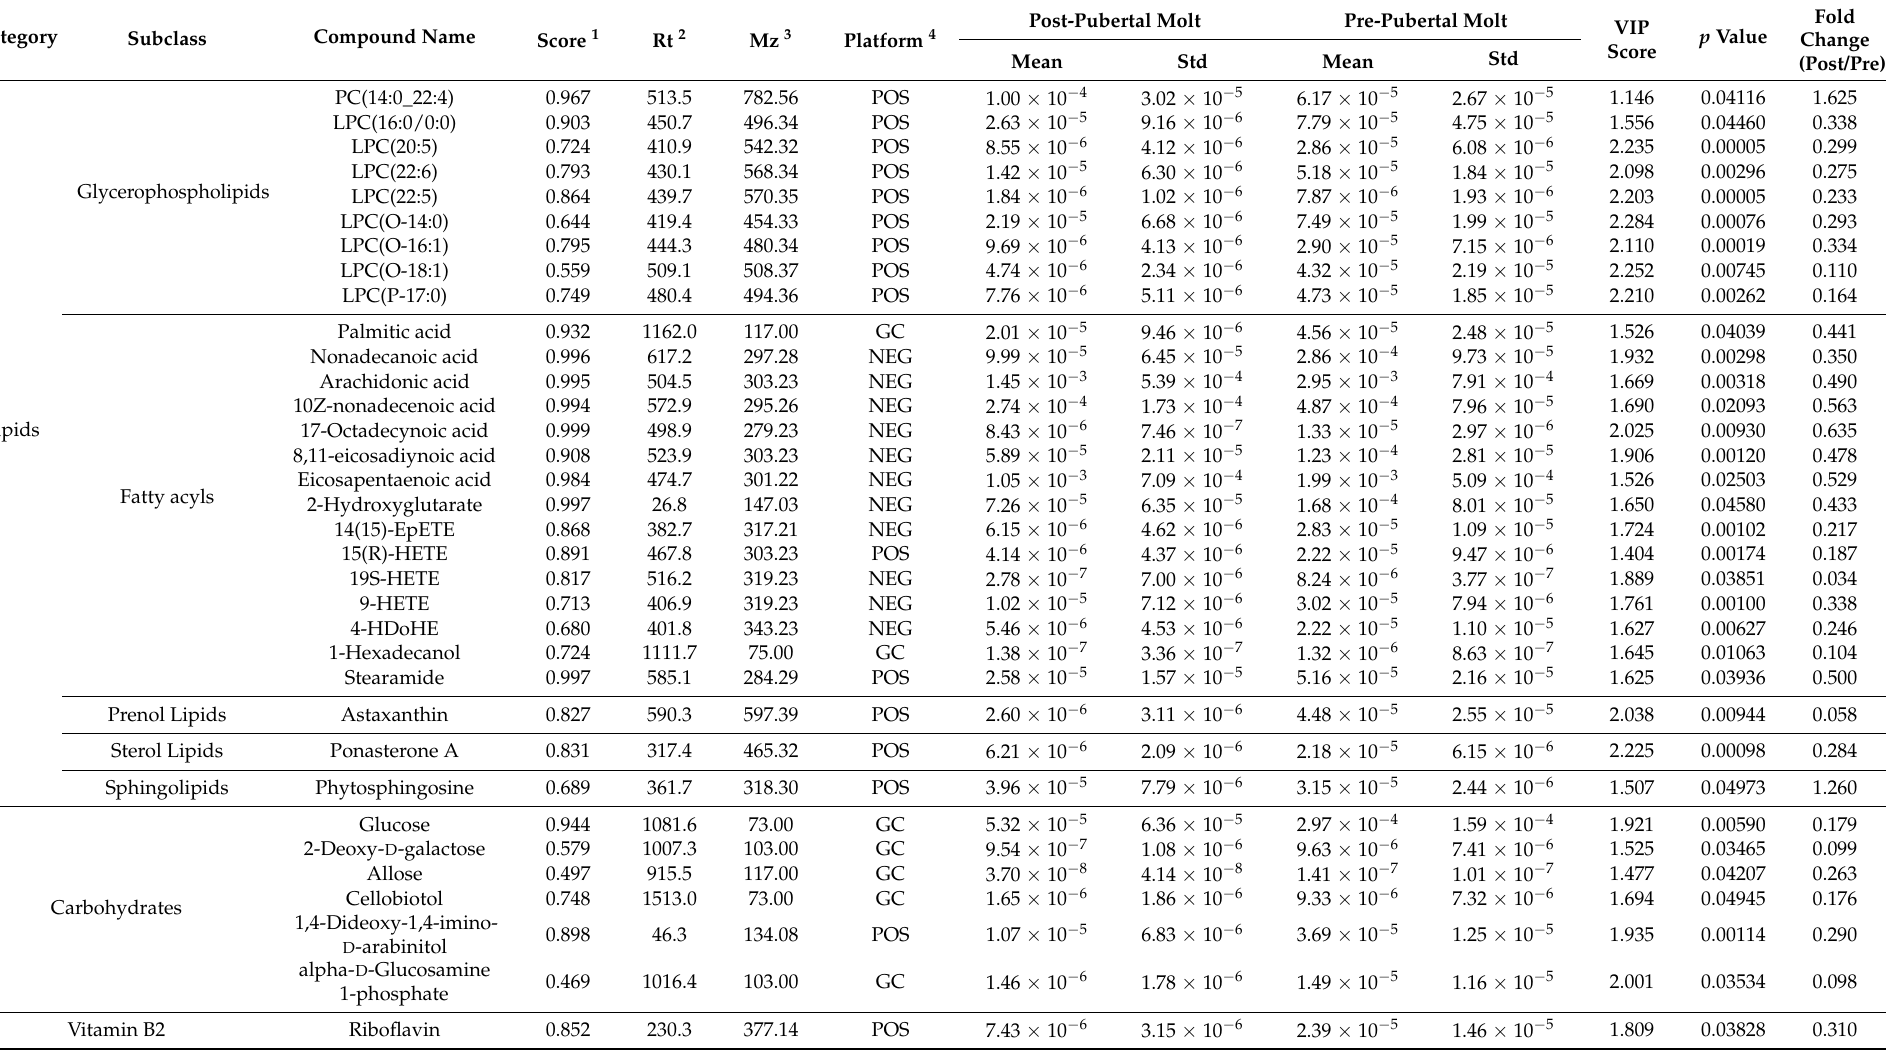
Table 1. Significantly changed metabolites between pre- and post-pubertal molt